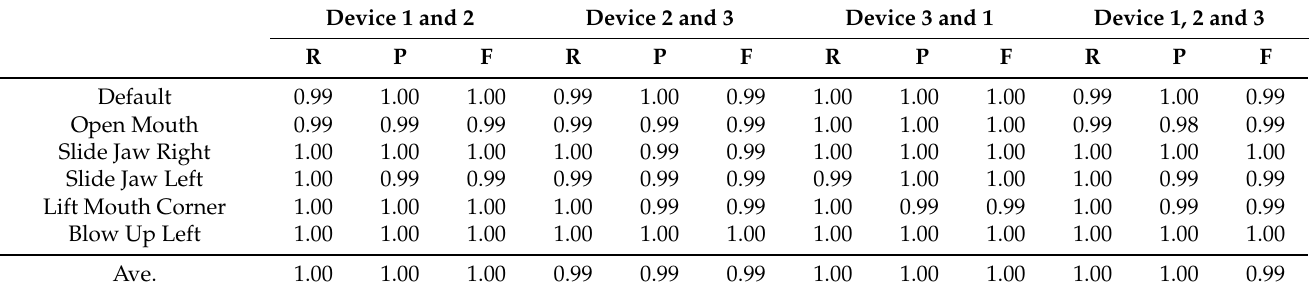
Table A4. The results of multiple device combinations for each gesture in Evaluation 2.